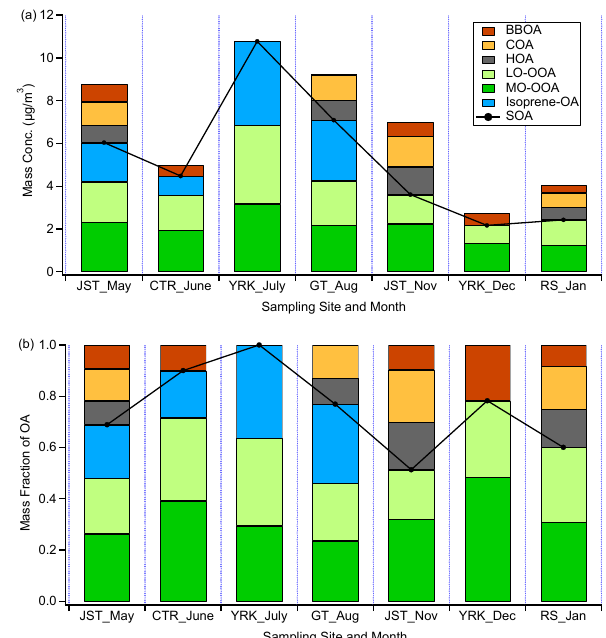
Figure 6. (a) Campaign-averaged mass concentrations of OA factors resolved from PMF analysis on organic mass spectra. (b) Campaign-averaged mass fractions of OA factors resolved from PMF analysis on organic mass spectra. SOA is the sum of isoprene- OA, MO-OOA, and LO-OOA. POA is the sum of HOA, COA, and